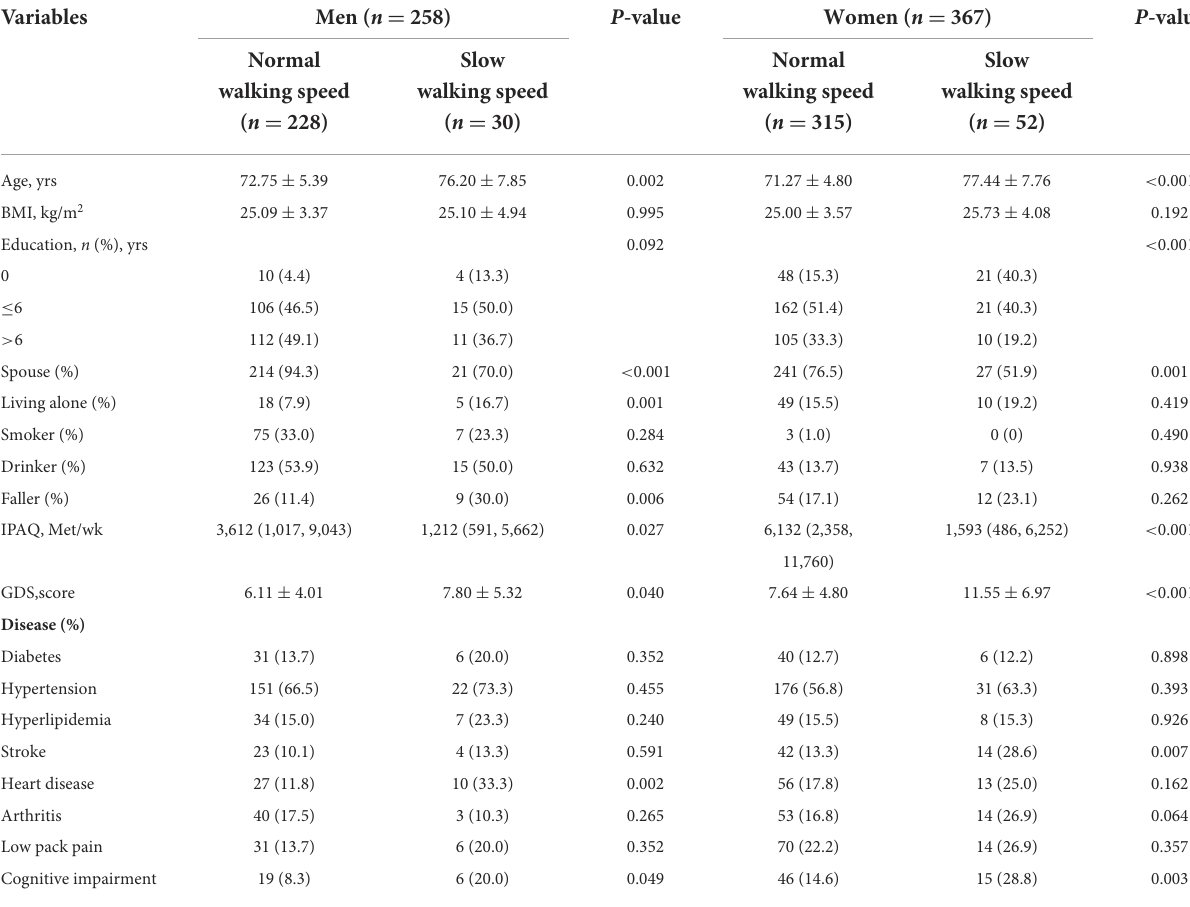
TABLE 1 Participant characteristics.